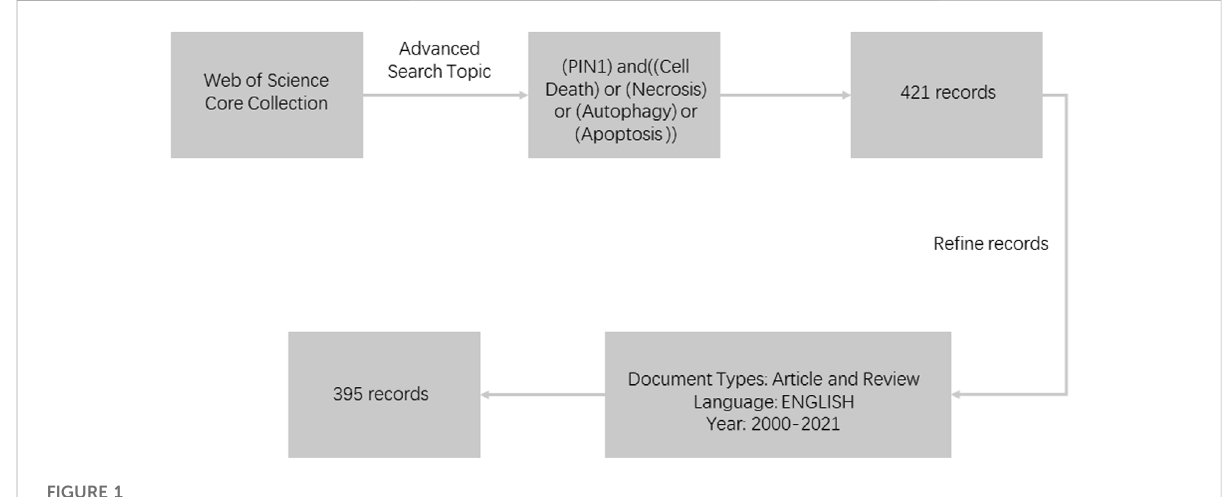
FIGURE 1 Flowchart of literature